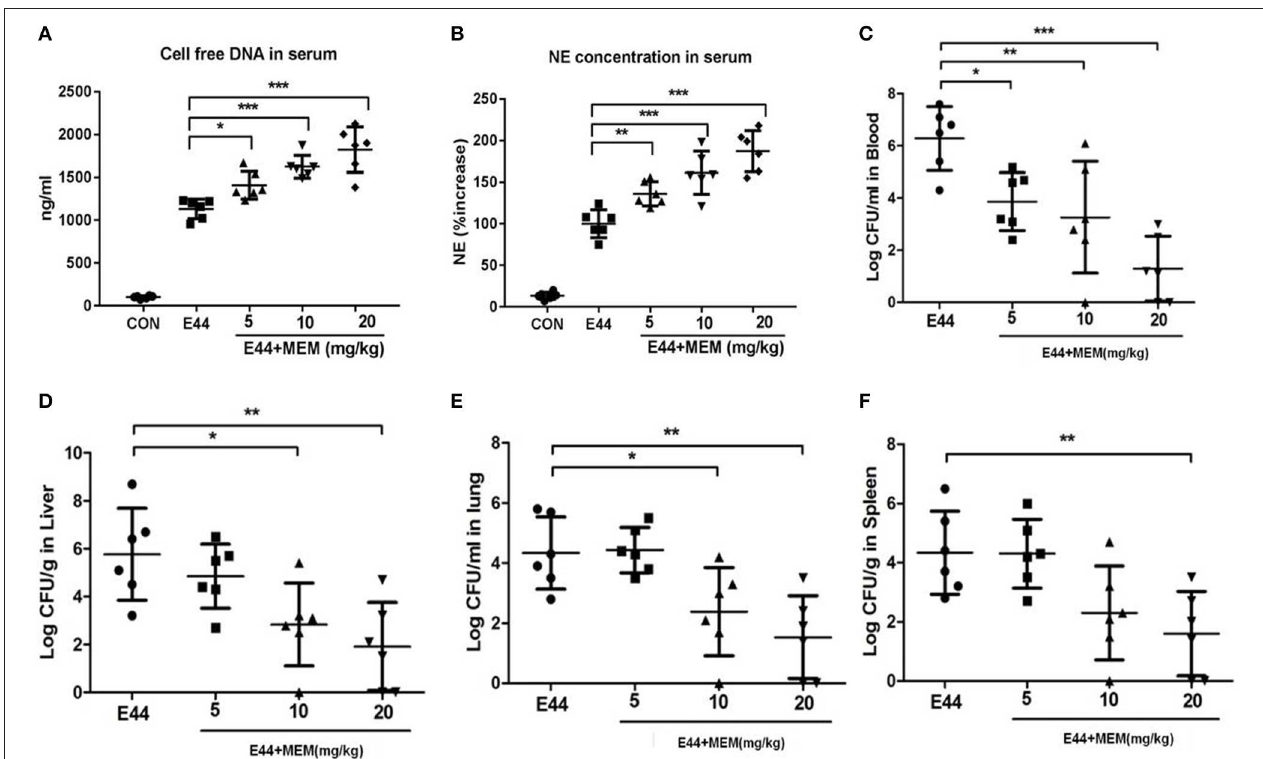
FIGURE 3 | MEM promoted NETs formation and could block E44 dissemination in mouse model. Mice (6 per group) were intraperitoneally injected with 2 × 10 7 E44 or with 2 × 10 7 E44 along with different concentrations of MEM (5–20mg/kg of body weight). After infection with E44 for 24h, mice were anesthetized and blood, liver, lung, and spleen tissue was collected. The serum used to detect the cell free DNA using Picogreen and NE using a Mouse PMN Elastase ELISA kit. For NE detection, the serum was diluted 1:2. The blood was diluted from 1:10 to 1:10 8 and cultured on BHI agar plates containing rifampicin. Liver, lung, and spleen tissue was weighed, triturated, diluted, and cultured on BHI agar plates containing rifampicin. (A) Cell free DNA in serum; (B) NE concentration in serum; (C) The bacterial levels in blood of mice; (D) The bacterial levels in liver tissue of mice; (E) The bacterial levels in lung tissue of mice; (F) The bacterial levels in spleen tissue of mice. The mice were treated as described in Materials and Methods, and then the blood, liver, lung, and spleen tissues were collected. Blood samples were diluted and cultured on the BHI agar plates. The liver, lung, and spleen tissues were weighted and triturated, then diluted and cultured on the BHI agar plates. All values represent the means of determinations. Bacteria levels in blood are expressed as log CFU/ml, and in tissues are expressed as log CFU/g. * P < 0.05, ** P < 0.01, *** P < 0.001.